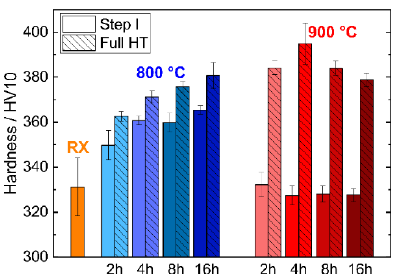
Figure 5. Vickers hardness in dependence of heat treatment temperature and duration after step I, i.e., aging at 800 °C or 900 °C and after the full heat treatment, i.e., step I + 750 °C/16 h.